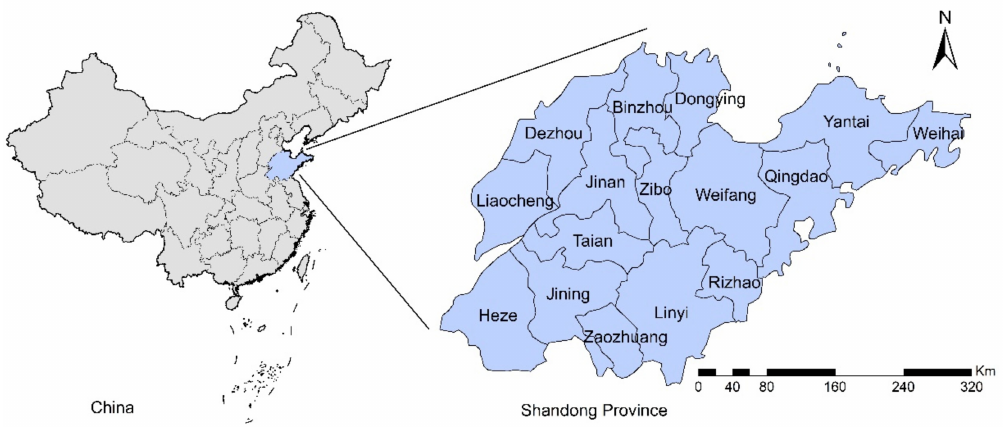
Figure 1. The geographical location of Shandong